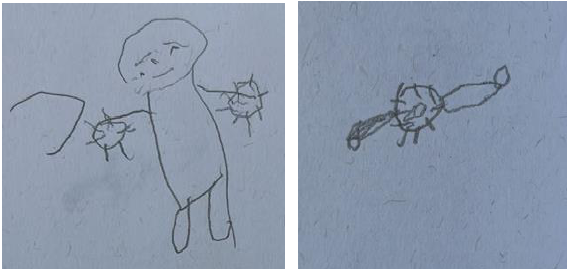
Figure 3. Self-figure drawing drawn by 70-year-old female undergoing hemodialysis or peritoneal dialysis: pre-diagnosis vs. at present.